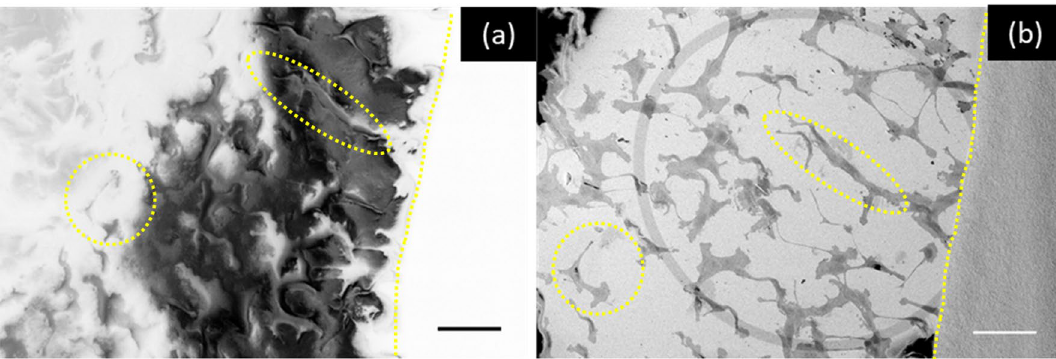
Figure 3. Charge dissipation and contrast enhancement on resin embedded U2OS cells after oxygen beam irradiation. Pre-irradiation ( a ) shows substantial charging and cellular contrast loss, which is greatly improved after irradiation ( b ). Scale bar : 100 µm. Circled regions indicate the same features on the sample without ( a ) and with ( b ) oxygen FIB exposure. The dotted line marks the border between carbon paste and